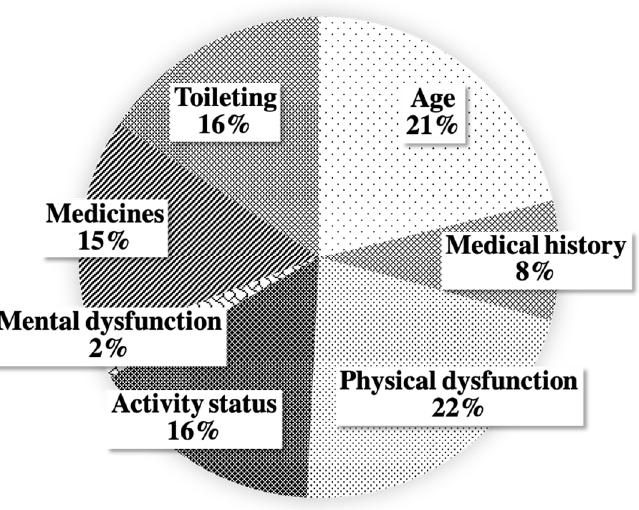
Figure 1. Percentage contribution of each category to the total fall risk assessment score (FRAS).